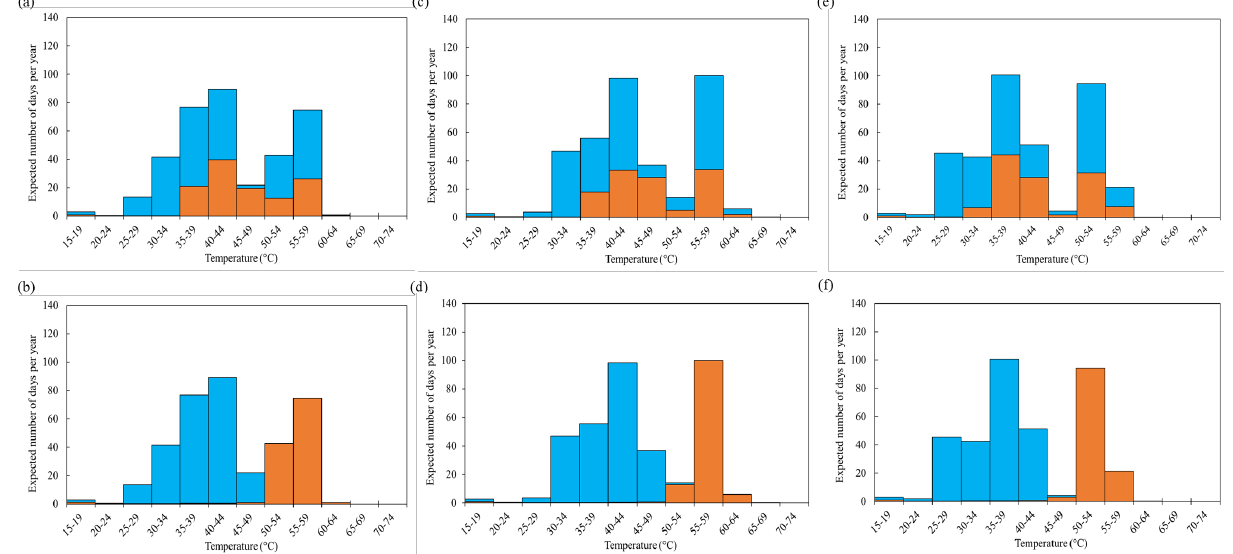
Figure 15. Correlation of influence factors at DP location: ( a ) min saturation under B1, ( b ) max parameter setting under B1, ( c ) min saturation under FSL, ( d ) max parameter setting under FSL, ( e ) min saturation under LSS, ( f ) max parameter setting under LSS.